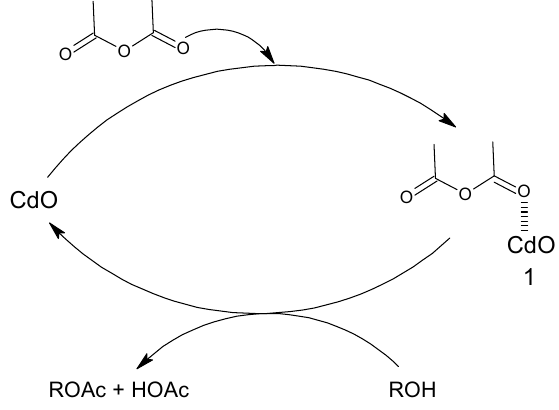
Scheme 1. Proposed mechanism for the acetylation of alcohols in the presence of CdO nanocatalyst.